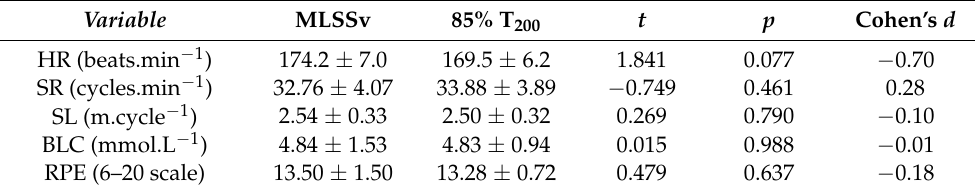
Table 3. Mean and standard deviation of performance markers during MLSS test and fourth repetition in the incremental step test, at 85% T 200